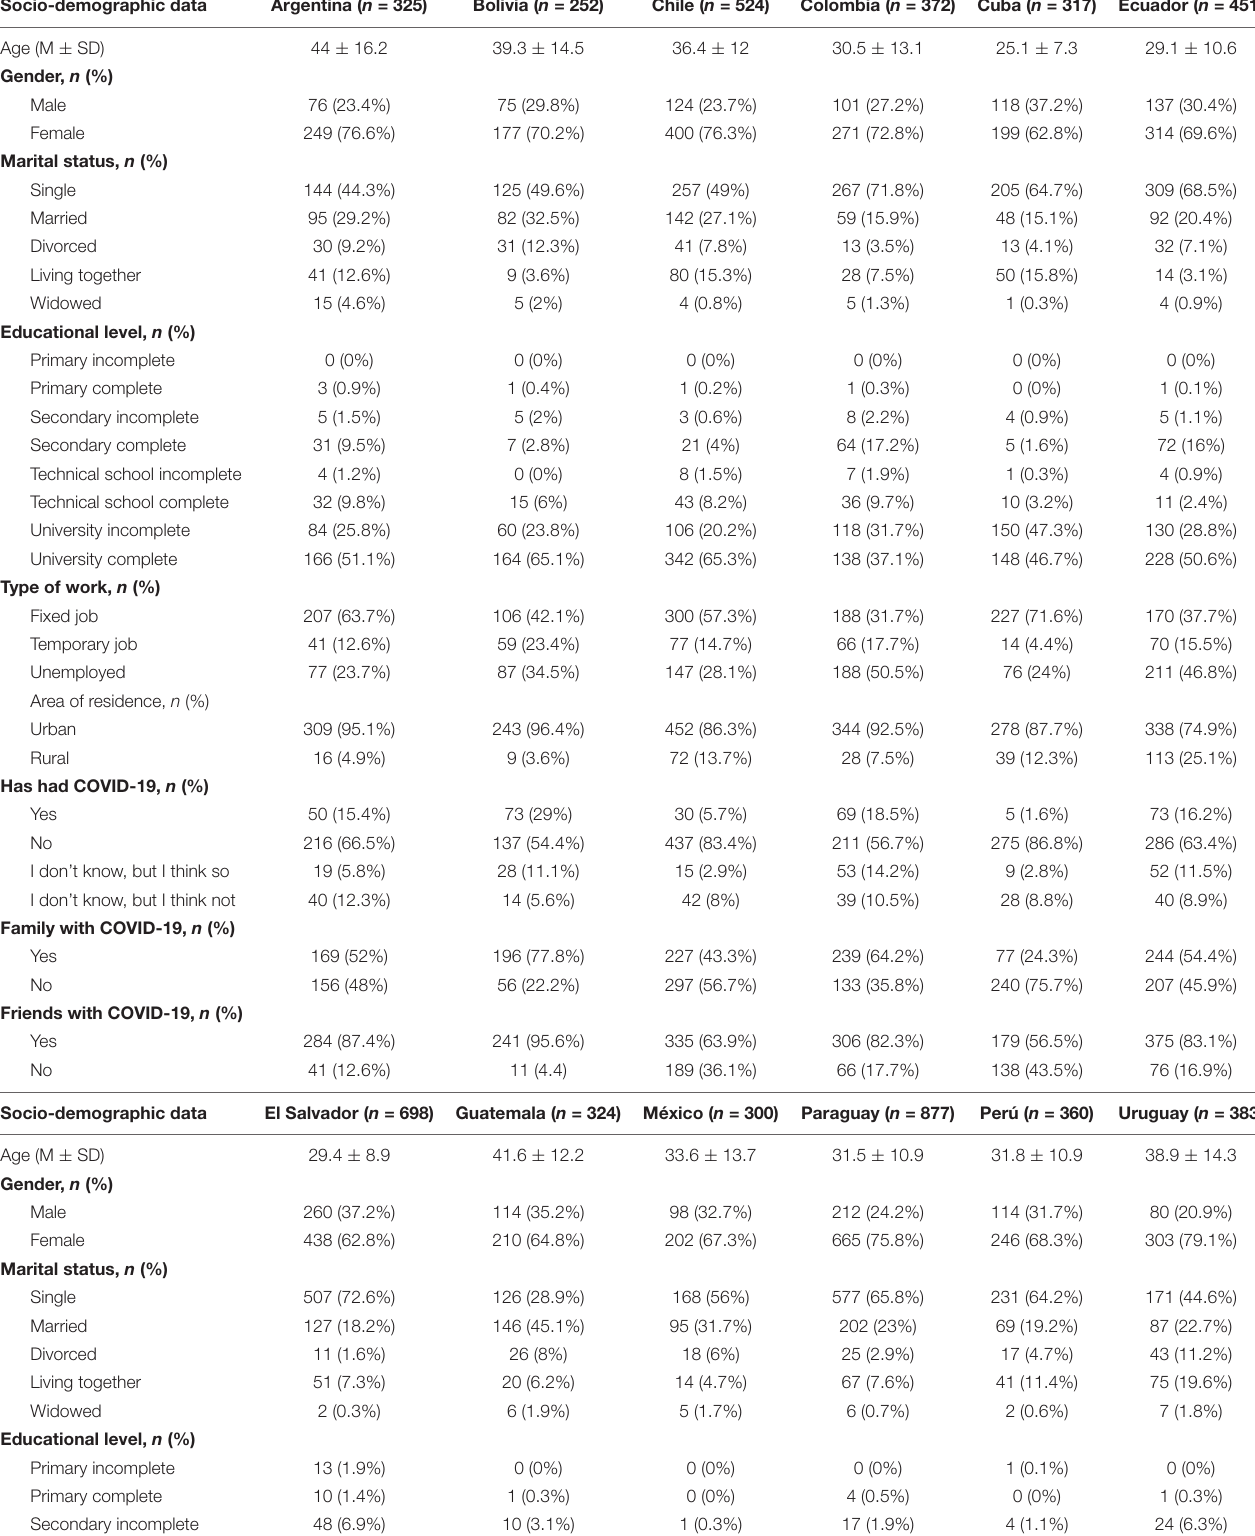
TABLE 1 | Sociodemographic characteristics of participants in the Americas. Socio-demographic data Argentina ( n =